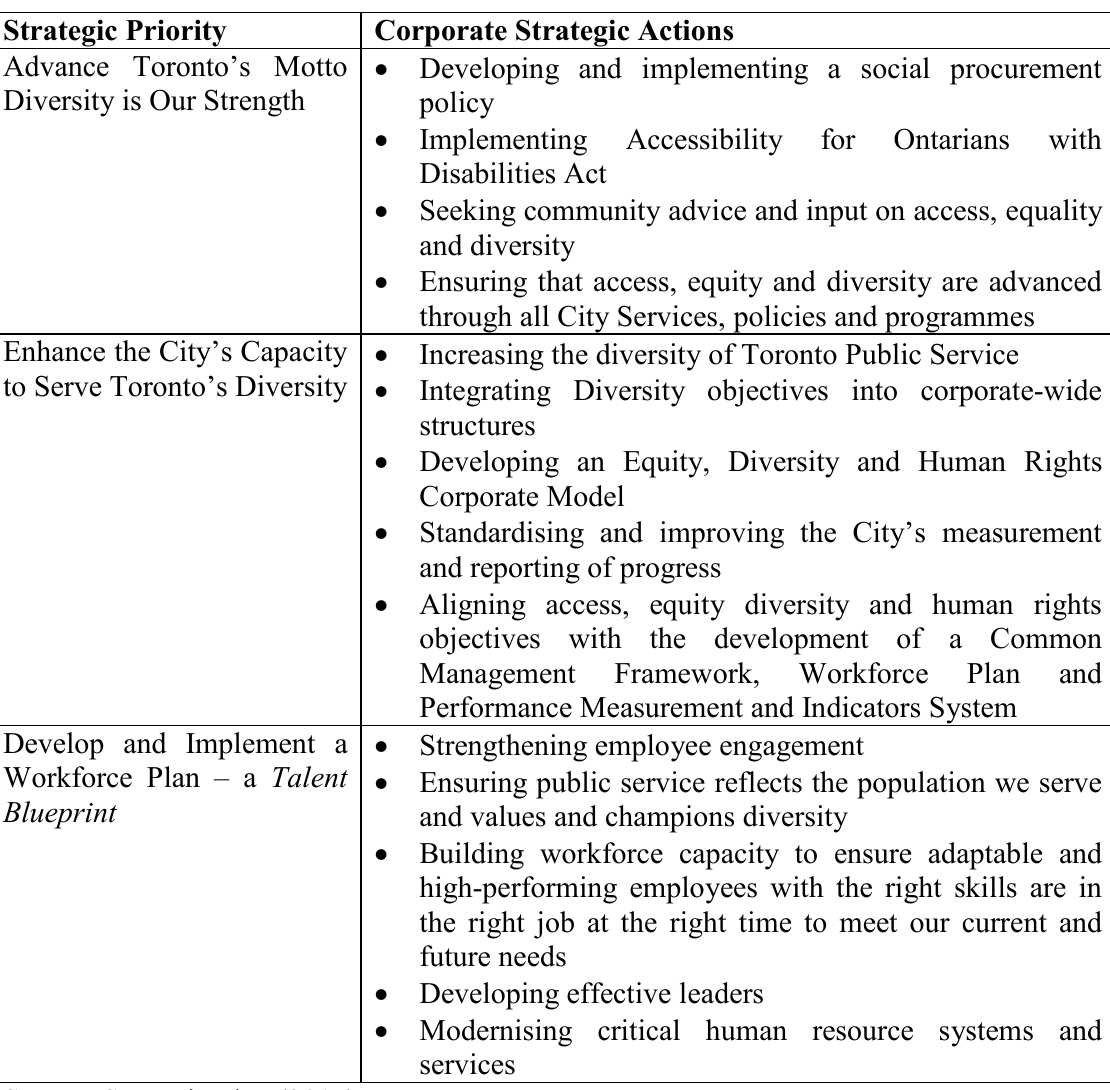
Figure 1: Toronto’s Corporate Strategic